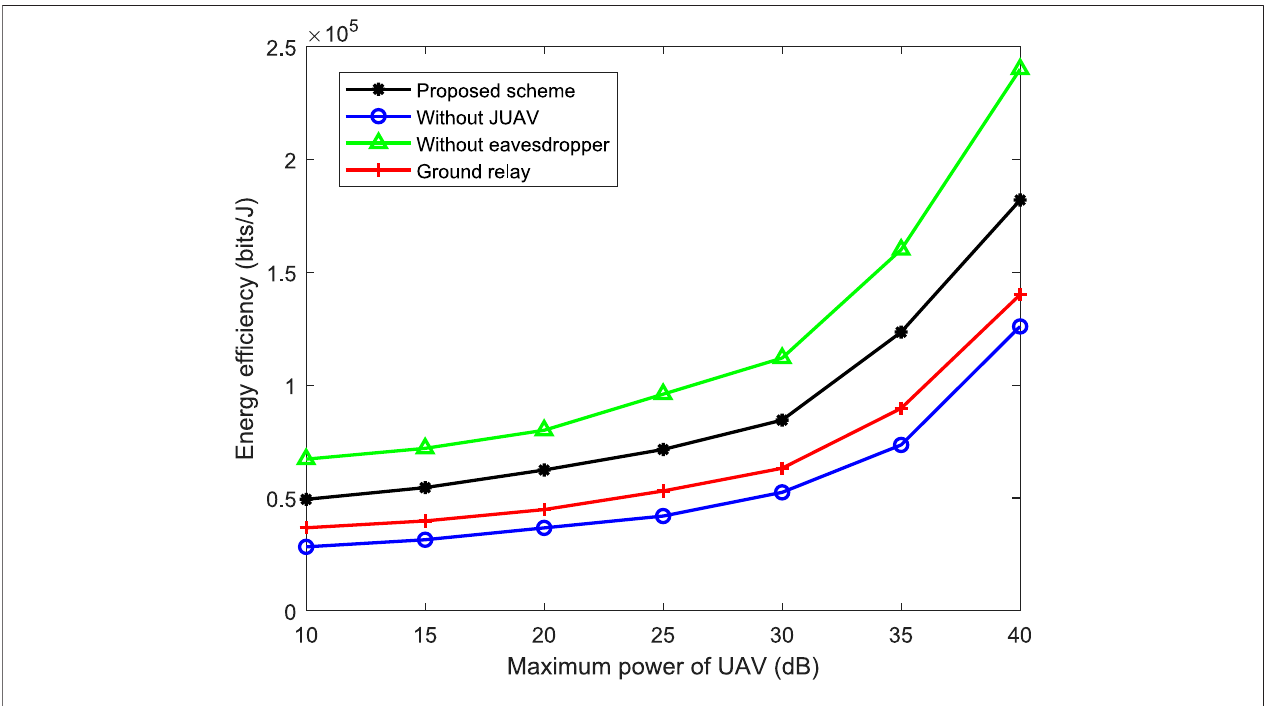
FIGURE 5 | Energy ef fi ciency vs. the maximum